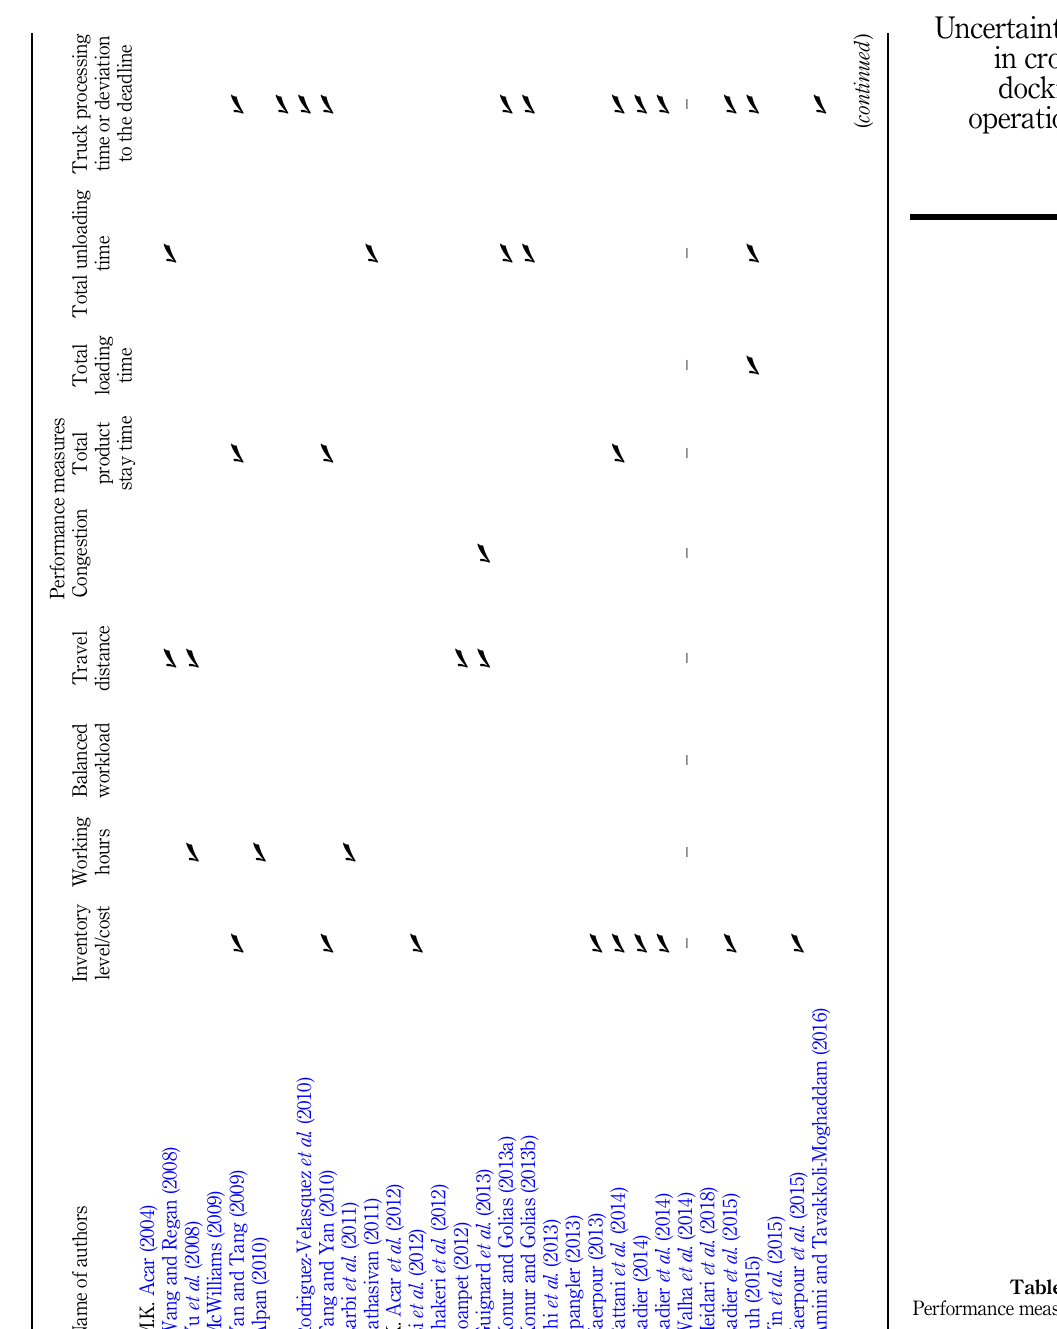
Table III. Performance